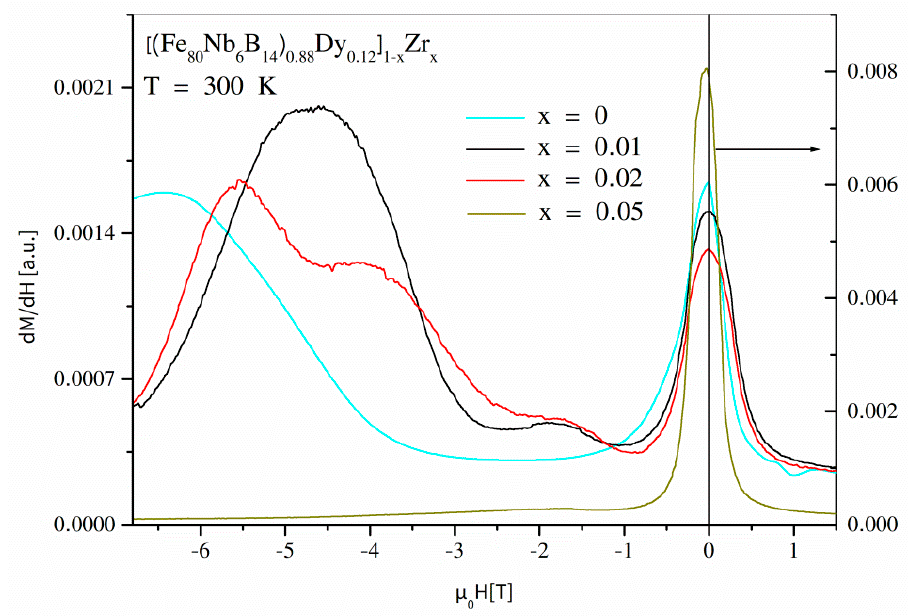
Figure 9. d M /d H dependencies for the [(Fe 80 Nb 6 B 14 ) 0.88 Dy 0.12 ] 1 − x Zr x (0 ≤ x ≤ 0.5) alloys determined at 300 K.